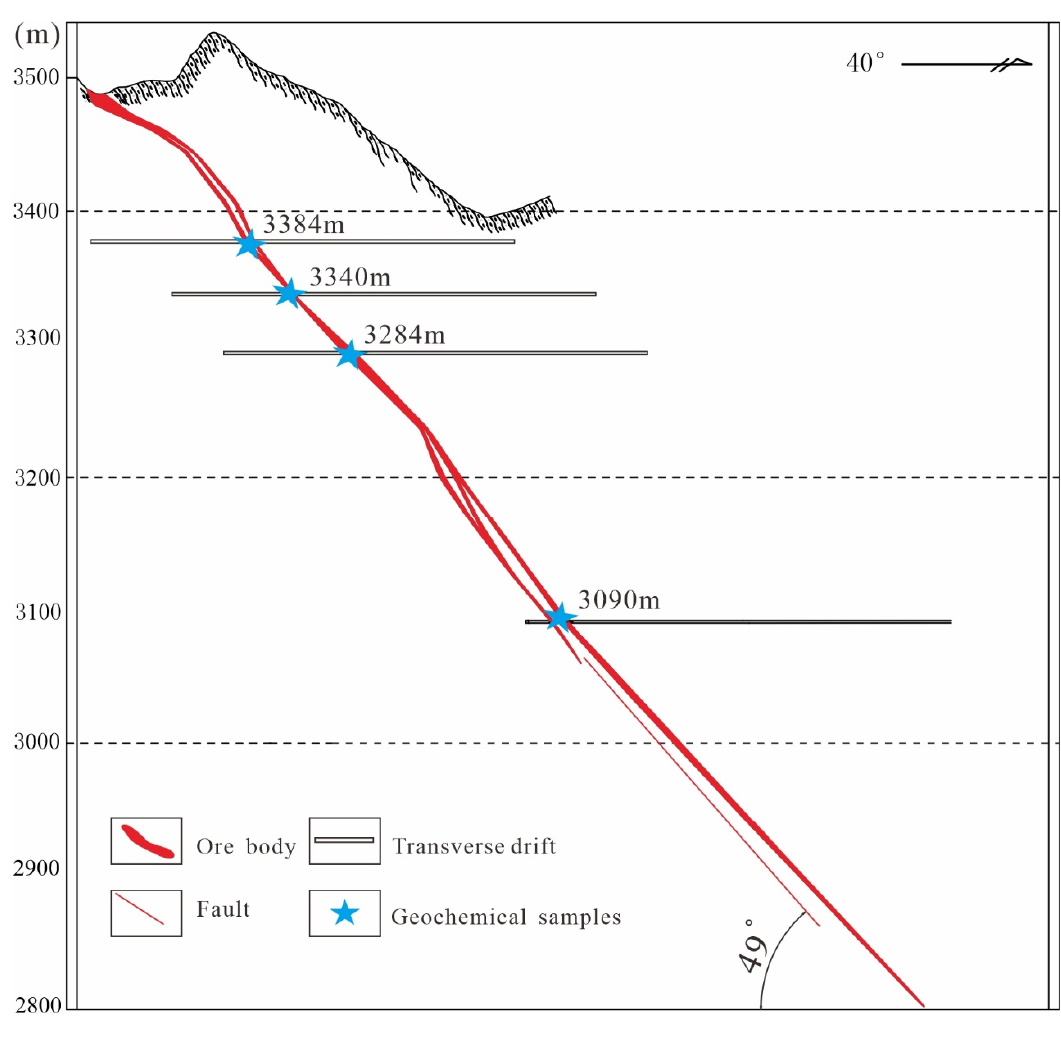
Figure 5. Schematic diagram of the sampling locations in the Yanjingou Au deposit.